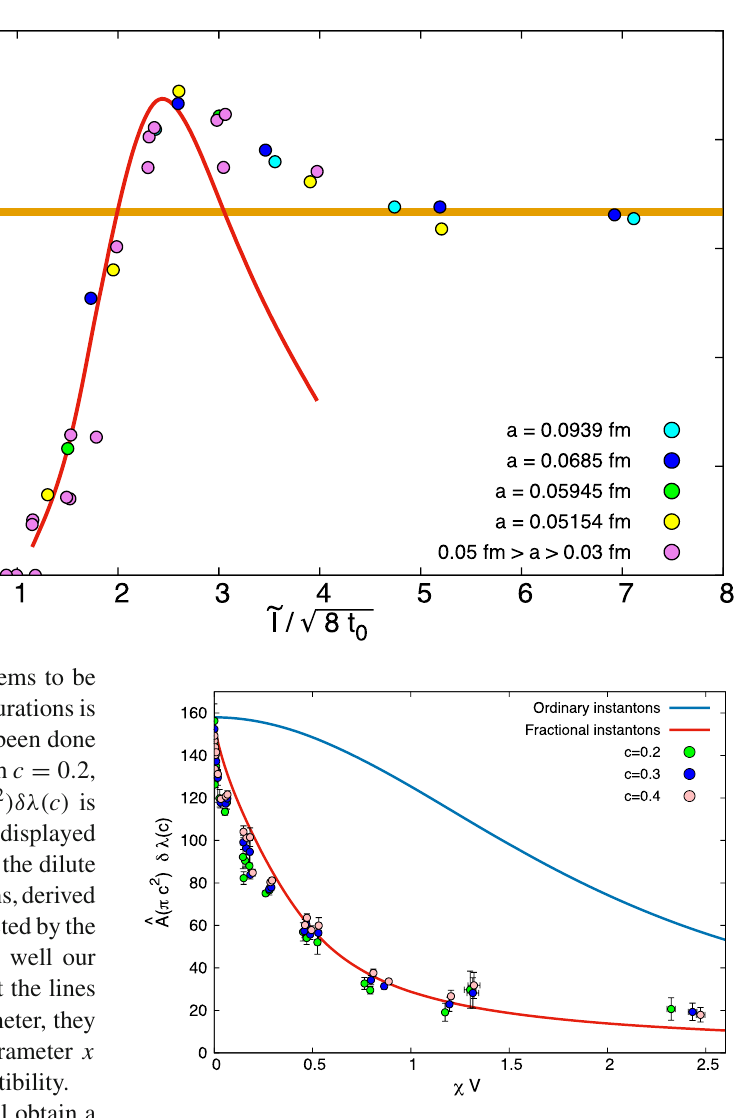
Fig. 10 Wedisplay # A (π c 2 )δλ( c ) = # A (π c 2 ) a function of χ V for couplings obtained at flow time 8 t = ( c ˜ l ) 2 , with c = 0 , 2, 0.3 and 0.4. The lines correspond to the estimate using the leading semi-classical contribution from either fractional or ordinary instantons. Note that these lines are not fits to the data, they are directly given by Eq. (4.7) with the parameter x determined from the measured value of the susceptibility